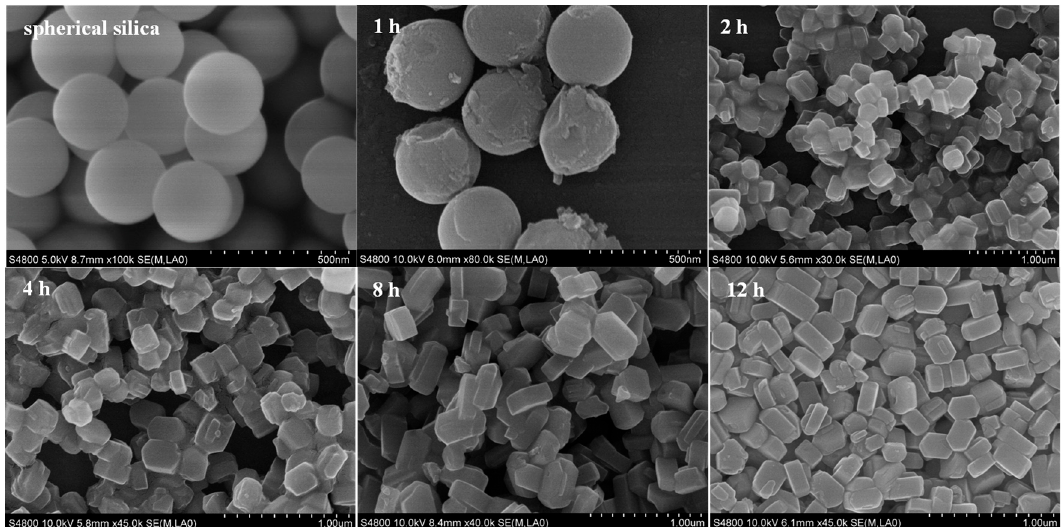
Figure 6. The SEM images of silicalite-1 synthesized from silica spheres of 300 nm. Table 1. Percent of crystallinities for silicalite-1 samples synthesized using different silica sources. 200 m 2 /g SiO 2 Time